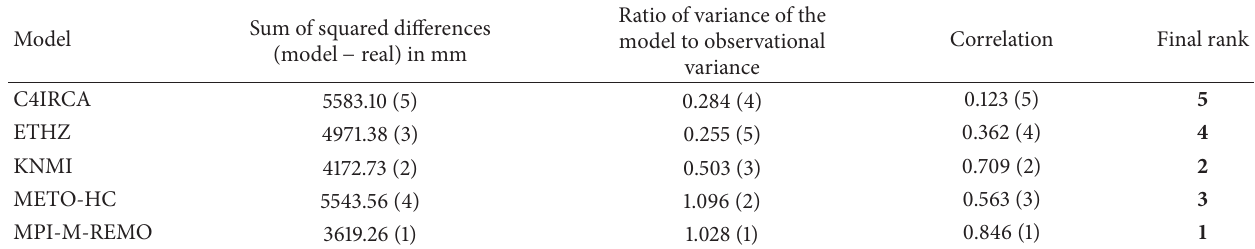
Table 3: Comparison of modelled and observed precipitation for the city of Poznan referring to second-order statistics: sums of squared differences, ratios of variances, and correlation coefficients (corresponding rank in brackets) and the final ranks for the models based on the precipitation.